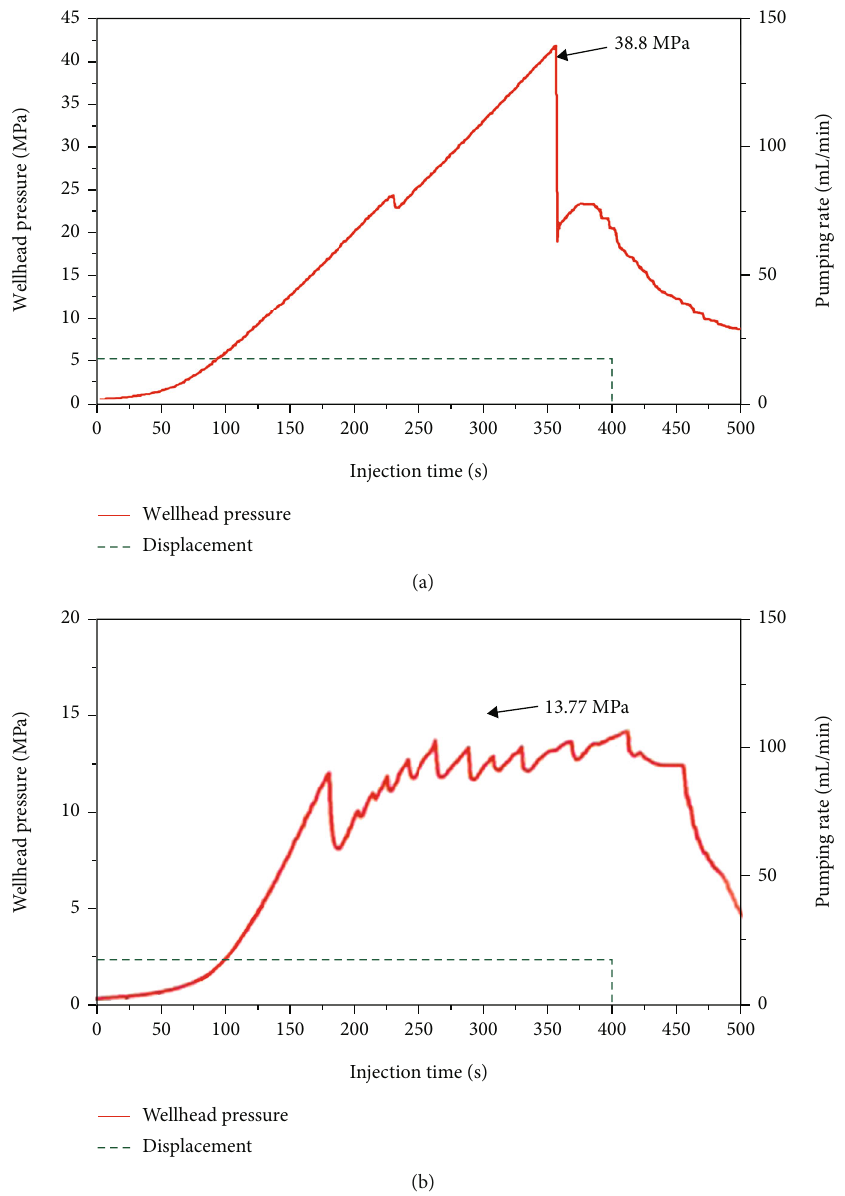
Figure 9: Injection pressure curve of di ff erent pumping rate pumps. (a) Sample 6#. (b) Sample